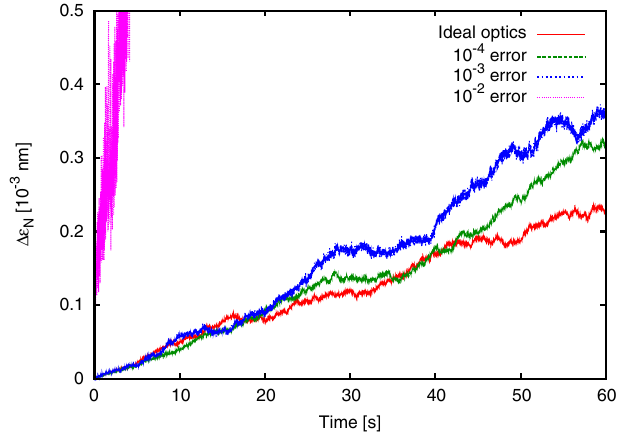
FIG. 14. (Color) Emittance growth vs time for an optimized feedback system using 30 BPM patterns (1324 BPMs) and 80 correctors with an expected emittance growth rate of roughly 0 : 28 (cid:5) 10 (cid:1) 3 nm = min (due to the few random seeds used, even the ideal optics clearly deviate from this value). Apart from the 1% error (with a growth rate of (cid:6) 7 (cid:5) 10 (cid:1) 3 nm = min ), the system is reasonably tolerant to the faulty system